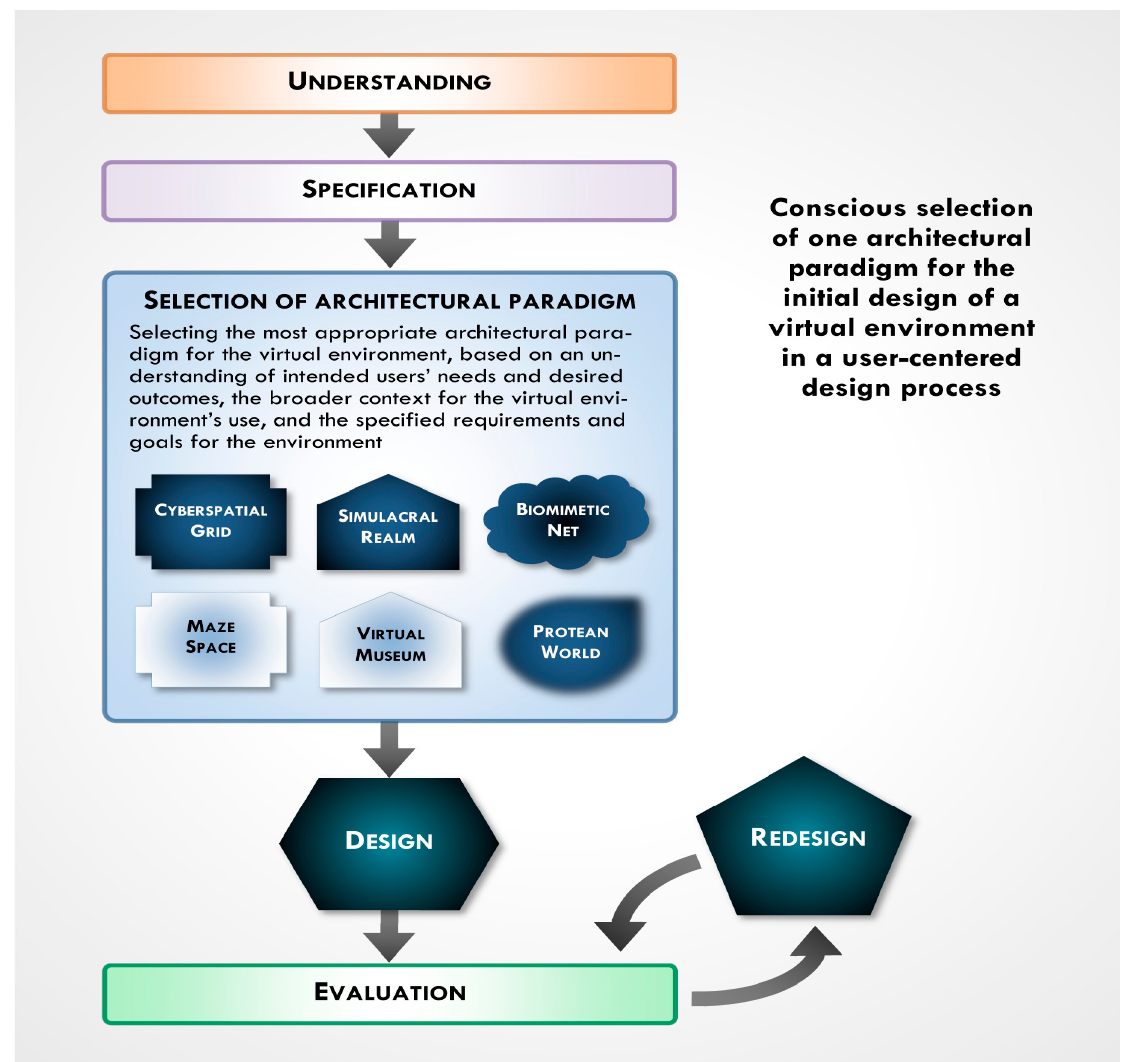
Figure 5. The proposed process of UCD for a virtual environment adds the explicit step of selecting an appropriate architectural paradigm.